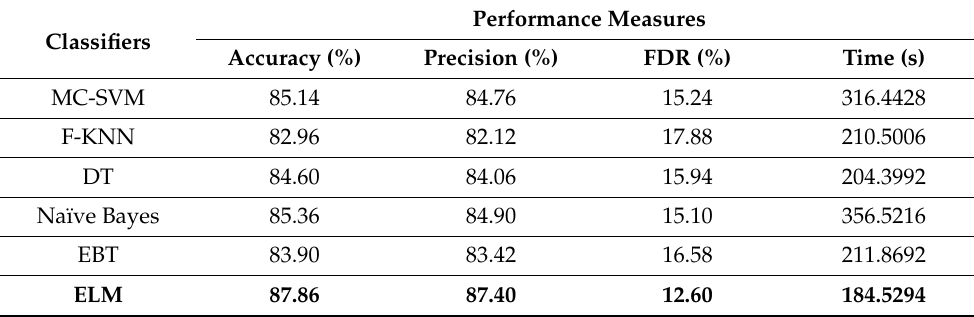
Table 6. Classification accuracy using HWOA-based feature selection for ISIC2018 dataset.